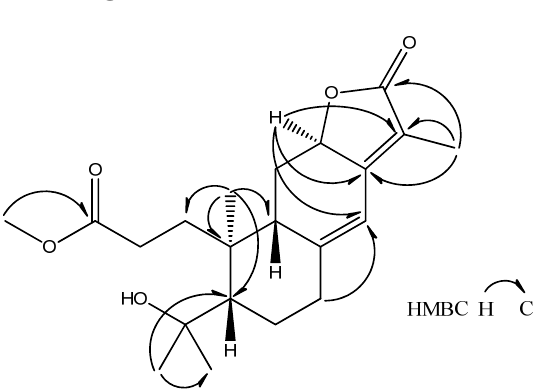
Figure 3. Selected HMBC of 1